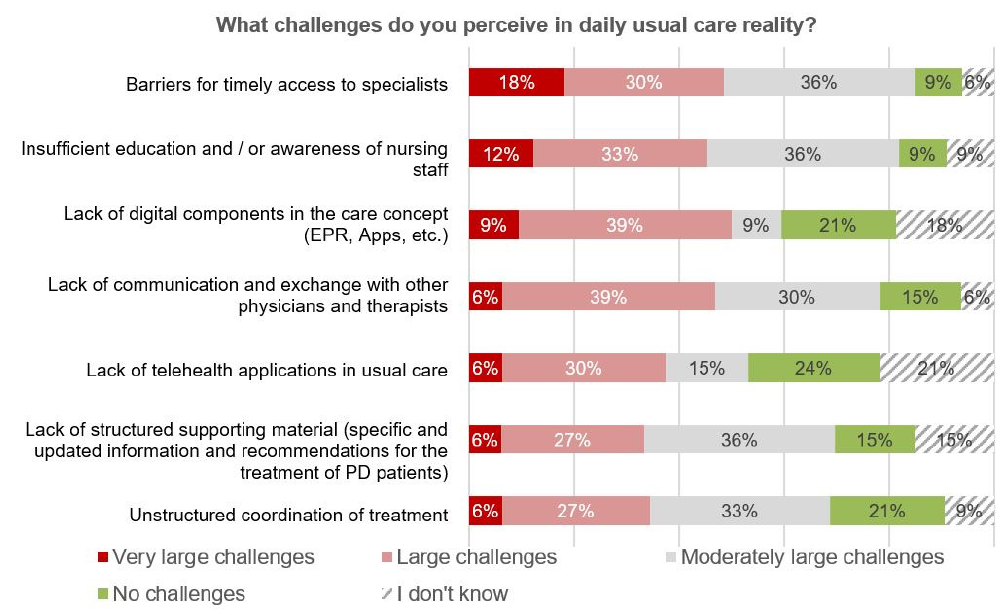
Figure 3. Survey results—perceived challenges in usual care reality ( n = 33).